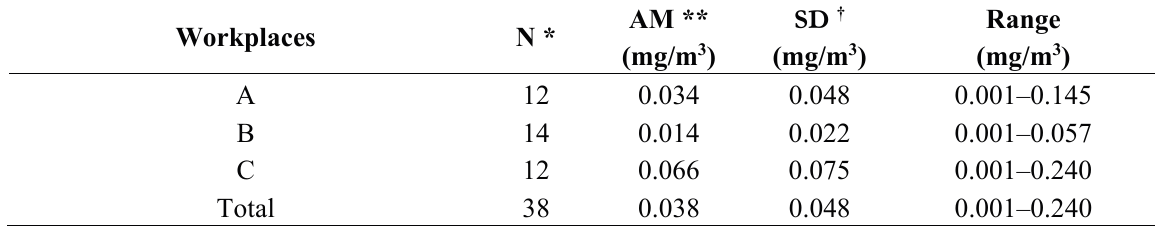
Table 4. The exposure measurement data of workplace environments.